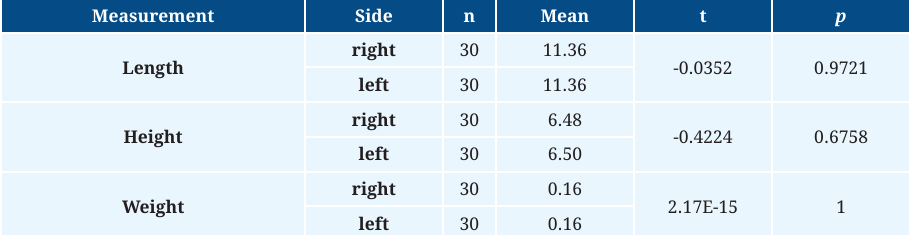
Neotropical Ichthyology, 18(3): e190106, 2020 11/16 ni.bio.br | scielo.br/ni